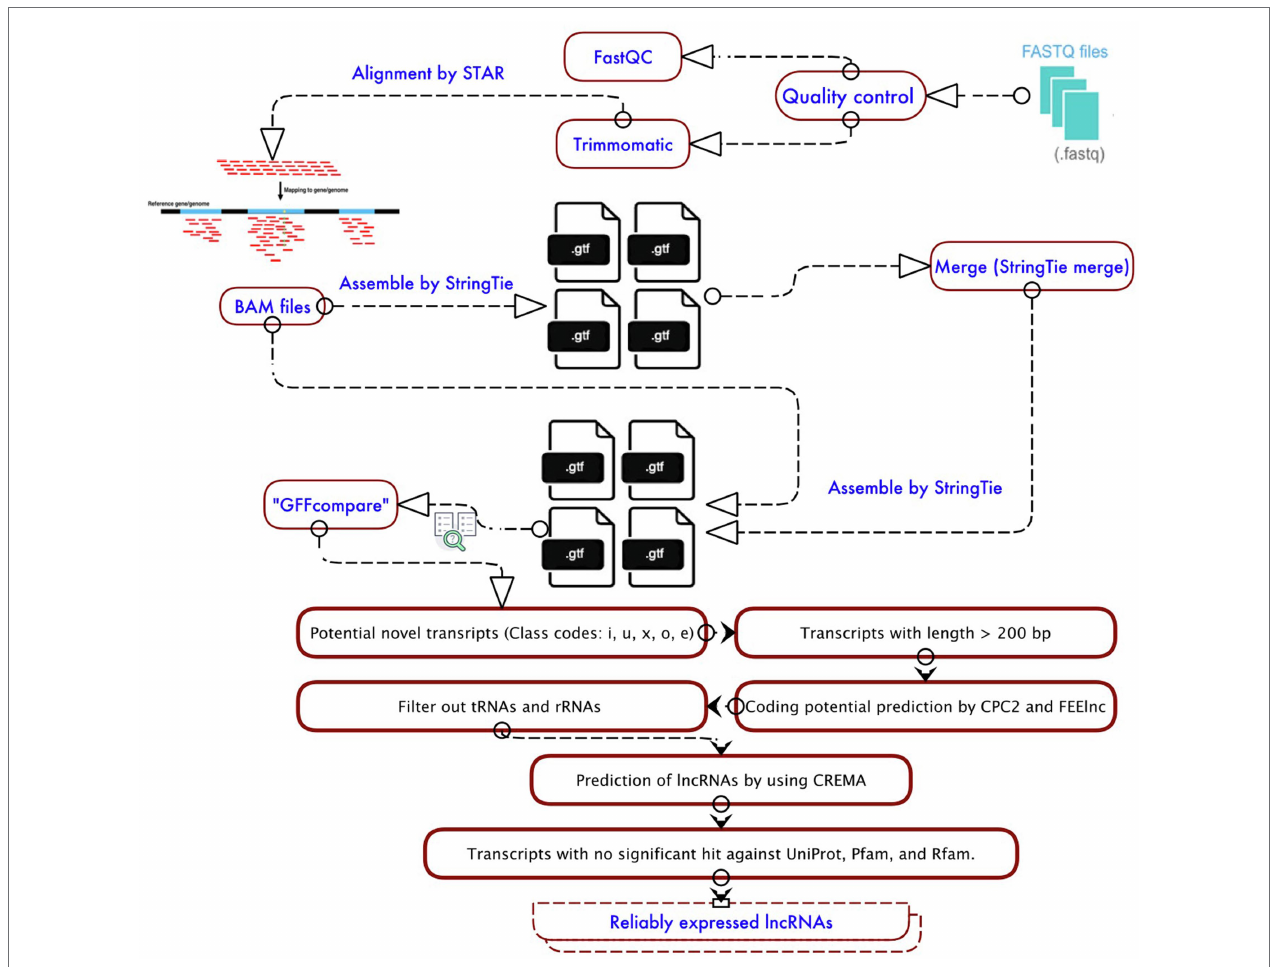
FIGURE 1 | Workflow of lncRNA identification from RNA-Seq data